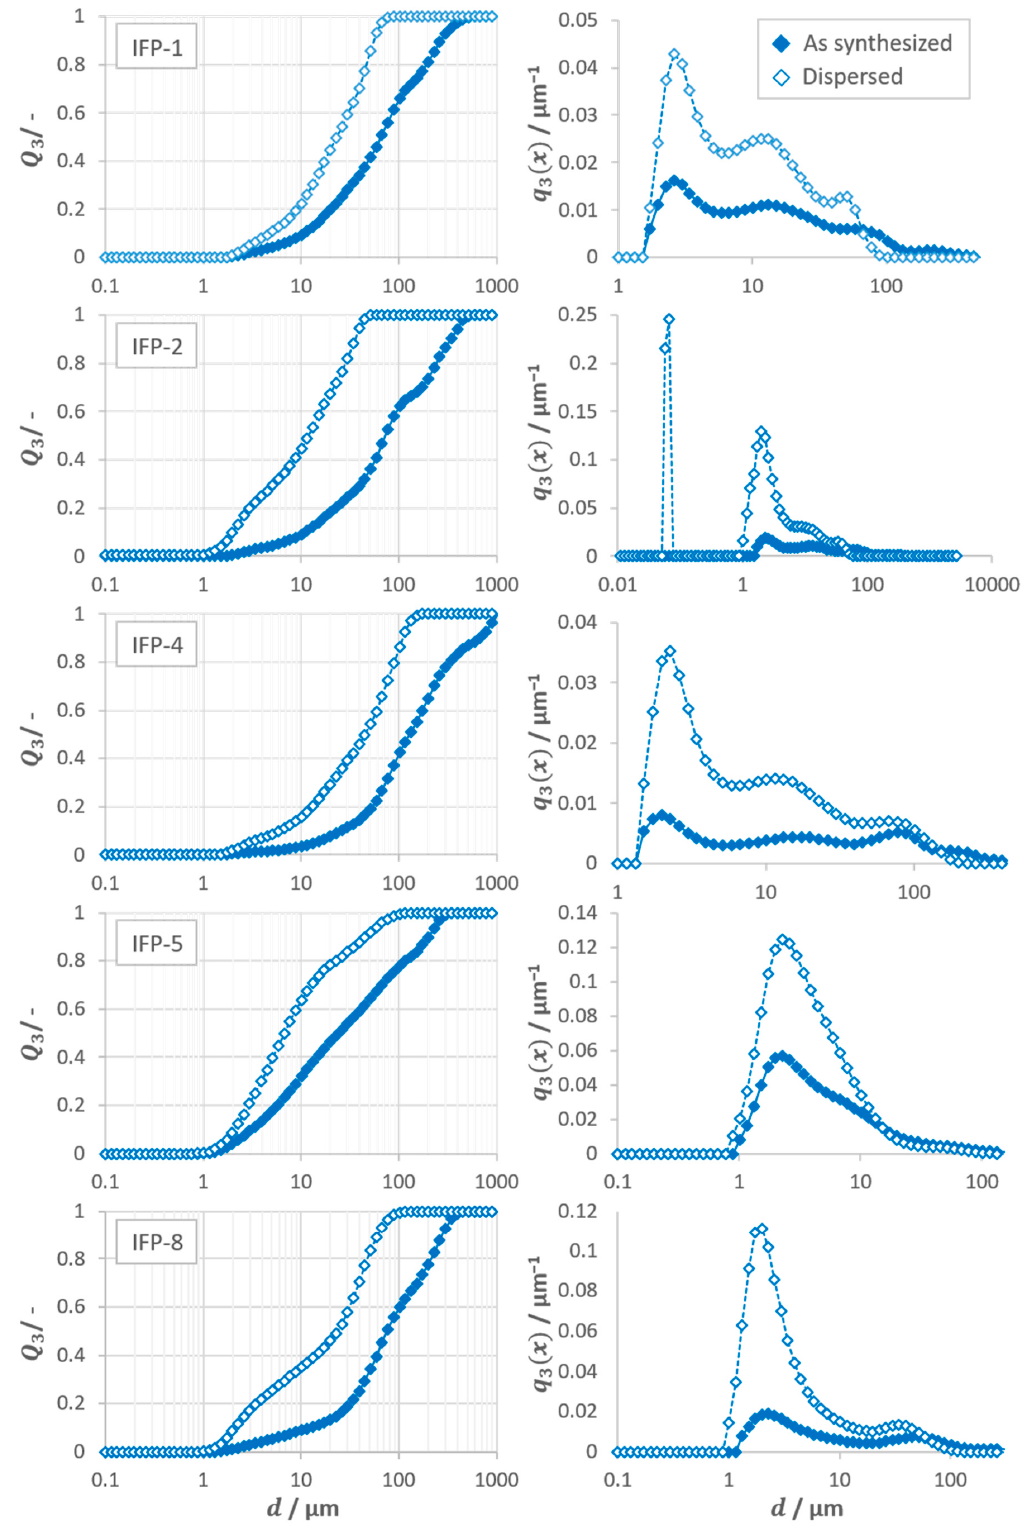
Figure A2. Volume sum distribution Q 3 ( x ) ( left column) and volume density distribution q 3 ( x ) ( right column) of all IFP samples before (full diamonds ◆ ) and after dispersion (empty diamonds ◇ ) .